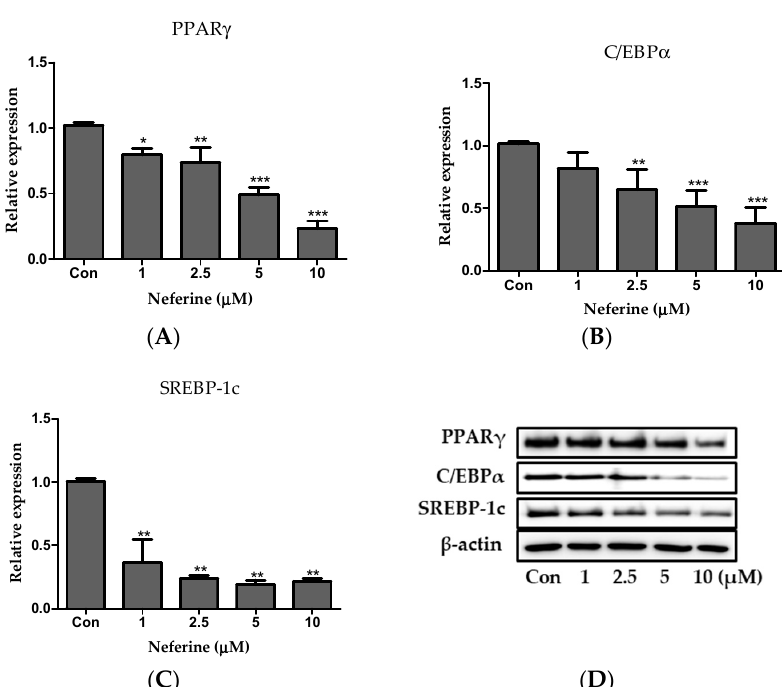
Figure 4. Effect of neferine on adipogenesis. Protein expression levels of ( A ) PPAR γ , ( B ) C/EBP α , and ( C ) SREBP-1c were analyzed by immunoblotting. ( D ) Immunoblot results of adipogenic factors in 3T3-L1 cells. These results are expressed following normalization with β -actin level. * p < 0.05, ** p < 0.01, and *** p < 0.001 vs. Con. All data are presented as mean ± SD, and experiments were performed at least thrice. The control (Con) was positive control that differentiated 3T3-L1 cells treated with adipocyte differentiation cocktail.